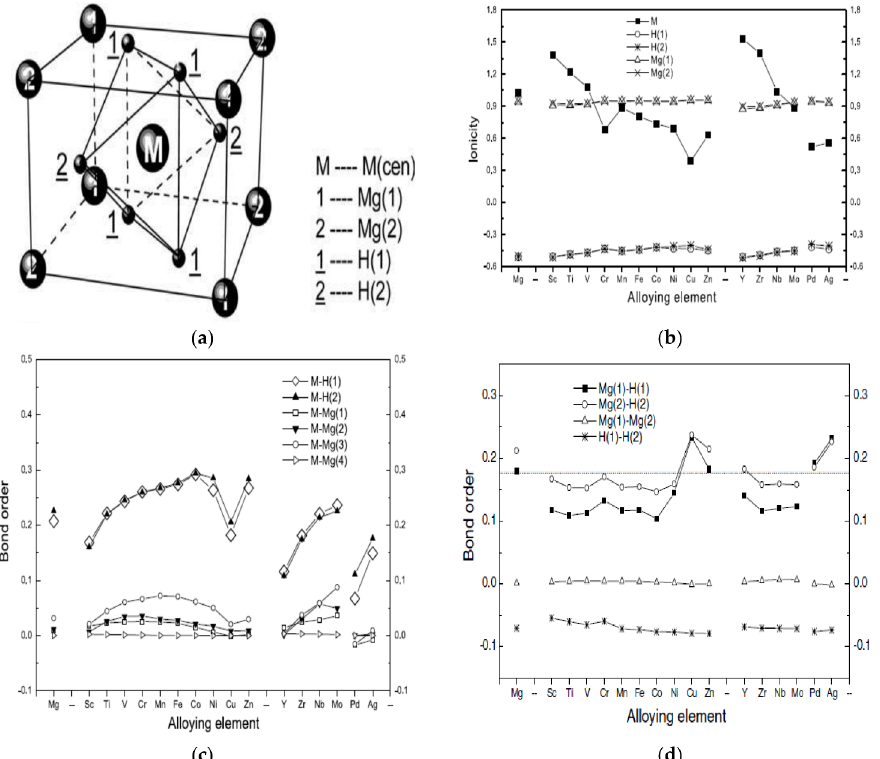
Figure 10. ( a ) The unit cell marked in cluster model of an alloyed magnesium hydride Mg(M)H 2 containing 32 magnesium atoms, 1 M atom, and 64 hydrogen atoms with the substitution of the central Mg atom in the cluster by an M atom. As noted above, H(1) and H(2) represent nnH, and Mg(1) and Mg(2) represent nnnMg. ( b ) Ionicities (net charges according to the Mulliken population analysis) of the central atom M and its adjacent H(1), H(2), Mg(1), and Mg(2) atoms vary with alloying element M in Mg(M)H 2 . ( c ) Bond order between the central atom M and its adjacent atoms varies with alloying element M. ( d ) Bond orders BO of the adjacent atomic pairs of Mg(1)–H(1), Mg(2)–H(2), Mg(1)–Mg(2), and H(1)–H(2) to M vary with the alloying element M. In this figure, M is the transition metal (TM) element mentioned in the text. ( a – d ) Reproduced with permission [182]. Copyright 2003,